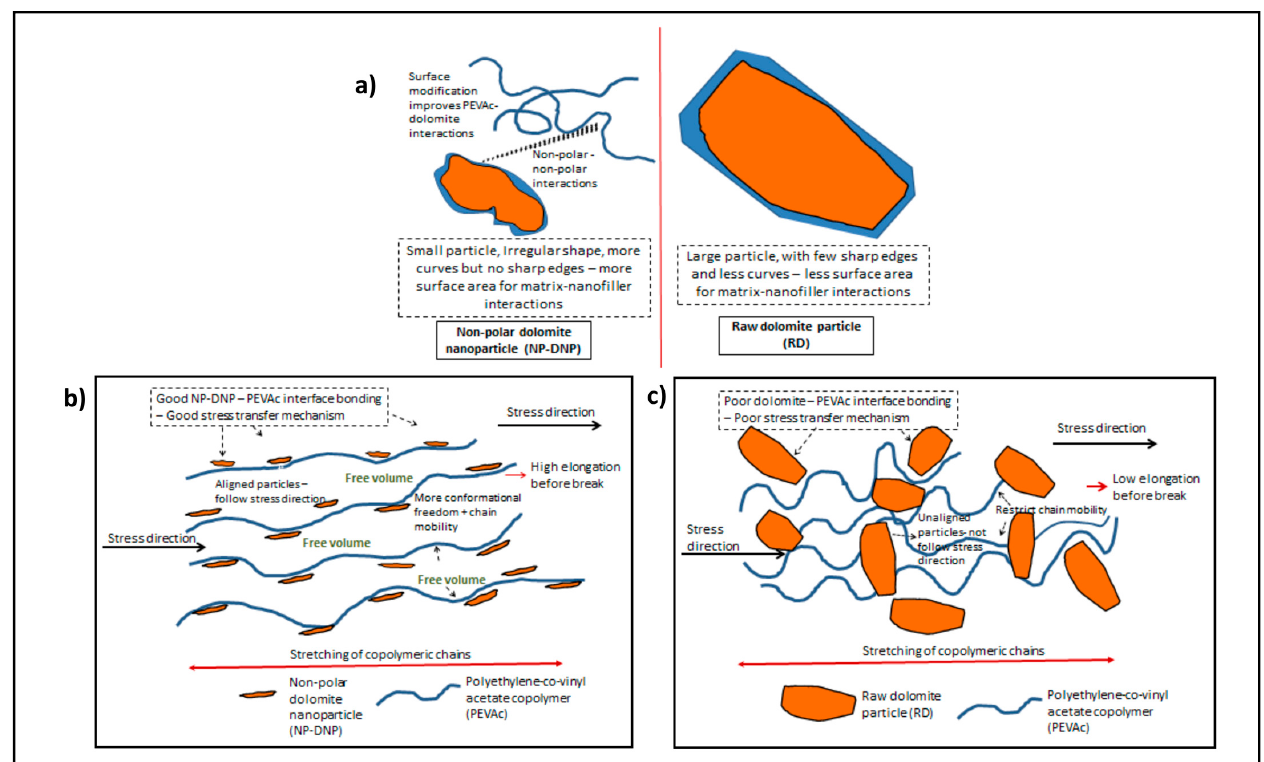
Figure 13. A comparison of ( a ) particle morphology and surface properties of non-polar dolomite nanoparticles (NP-DNPs) and raw dolomite (RD), ( b ) NP-DNP nanofiller effect on the strain behavior of the PEVAc copolymer, and ( c ) RD filler effect on the strain behavior of the PEVAc copolymer. On the contrary, the modulus of elasticity values for the PEVAc decreased with the addition of both the DNP and NP-DNP nanofillers. The PEVAc/RD showed a greater